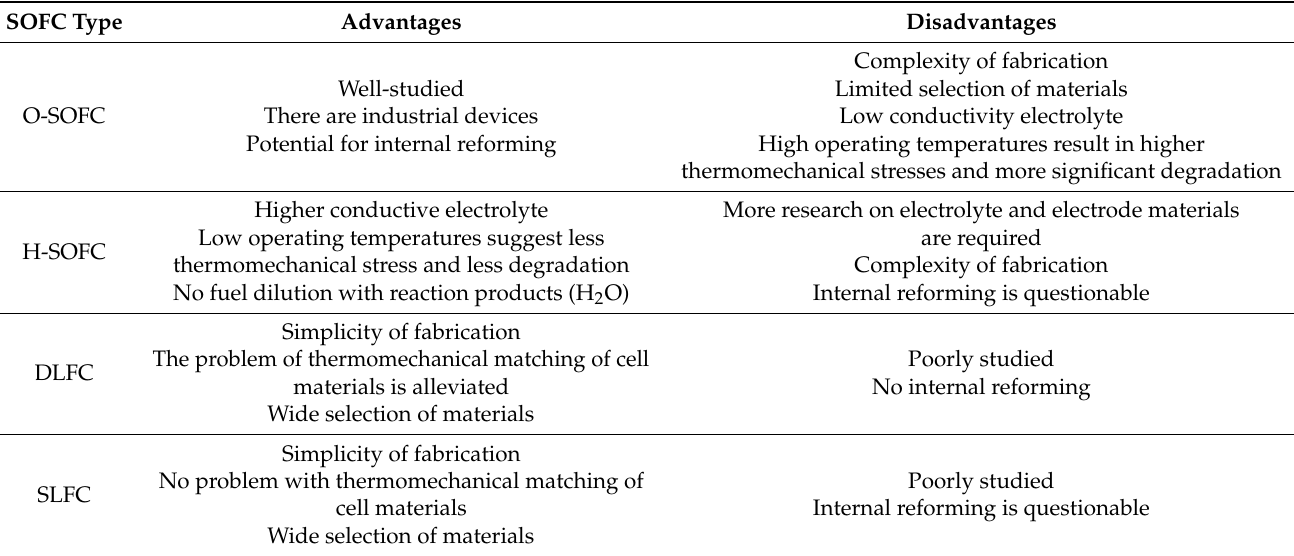
Table 1. Features of O-SOFC, H-SOFC, and FEFC.